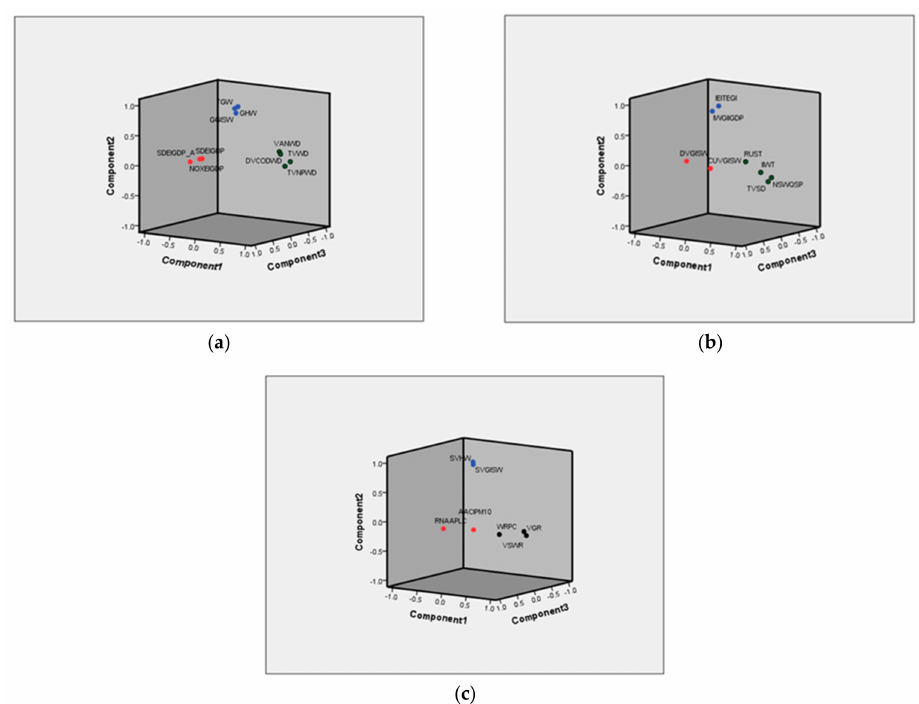
Figure 1. Principal Component Analysis Diagram of Environmentally Sustainable Development; ( a ) Principal Compo- nent Analysis Diagram of Pressure of Environmentally Sustainable Development; ( b ) Principal Component Analysis Diagram of State of Environmentally Sustainable Development; ( c ); Principal Component Analysis Diagram of Response to Environmentally Sustainable